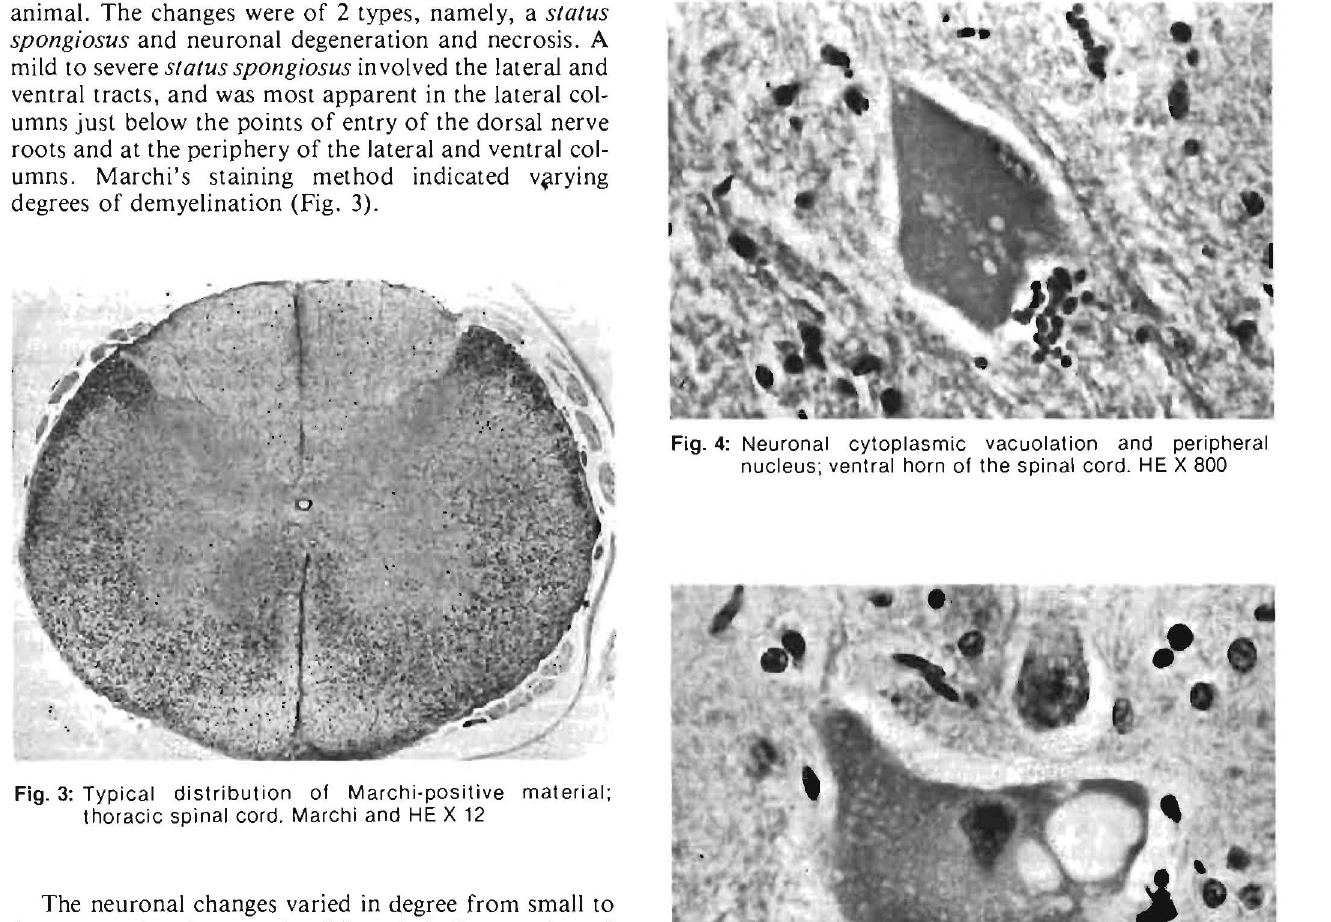
Fig. 3: Typical distribution of Marchi·positive material; thoracic spinal cord. Marchi and HE X 12